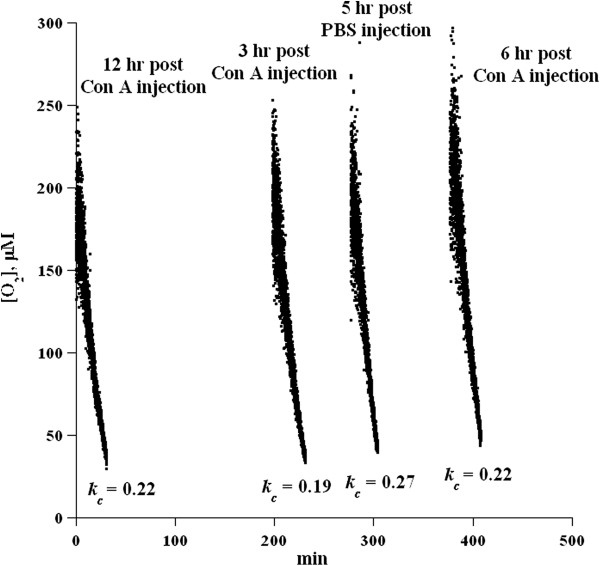
Time-dependent changes in liver respiration in ConA hepatitis in C57Bl/6 IFN-γ−/−mice. Mice were injected with 20 mg ConA/kg and liver specimens (24–29 mg) were collected for O2 measurements at 3, 6, and 12 hr post-injection. Control mice were injected with PBS. Rates of respiration (kc, in μM O2 min-1 · mg-1) are shown at the bottom of the runs. All four runs were performed on one instrument. One animal was sacrificed at-a-time in the following sequence: 12 hr post-injection, 3 hr post-injection, PBS, and then 6 hr post-injection. Minute zero corresponds to sacrifice of the first animal.